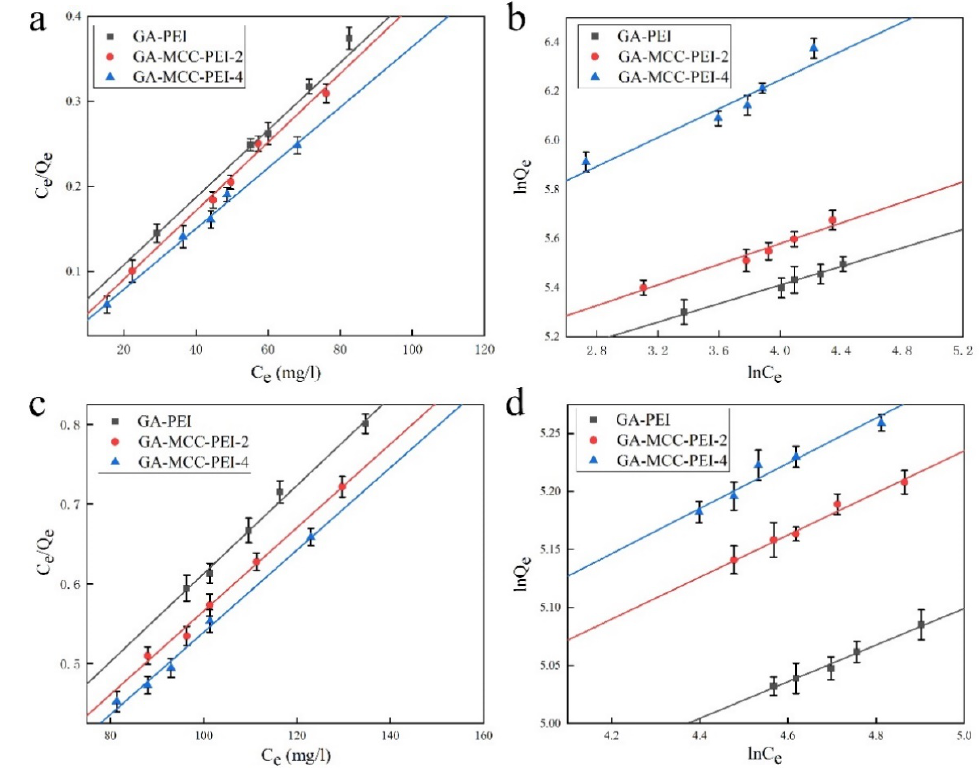
Figure 10. Fitting of adsorption isotherms: Langmuir ( a , c ) and Freundlich ( b , d ) isotherms for the adsorption of amaranth ( a , b ) and methylene blue ( c , d ) by GA-PEI, GA-MCC-PEI-2, and GA-MCC- PEI-4.